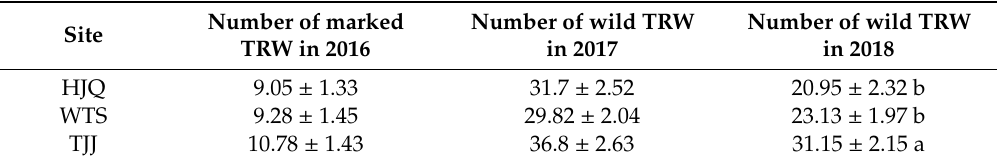
Table 2. The number (means ± SE) of tree-of-heaven root weevils (TRW), Eucryptorrhynchus scrobiculatus, caught per monitoring trunk trap net (MTTN) on trees at Haojiaqiao (HJQ), Wutongshu (WTS), and Taojiajuan (TJJ). Means followed by di ff erent letters within the same column are significantly di ff erent (Tukey’s HSD, α = 0.05). Number of Site